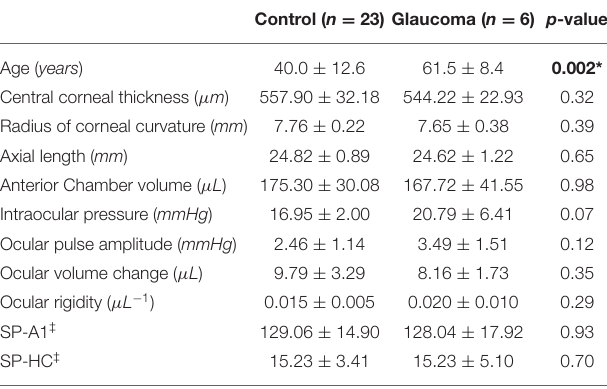
TABLE 1 | Demographic and ocular characteristics of all subjects ( n =